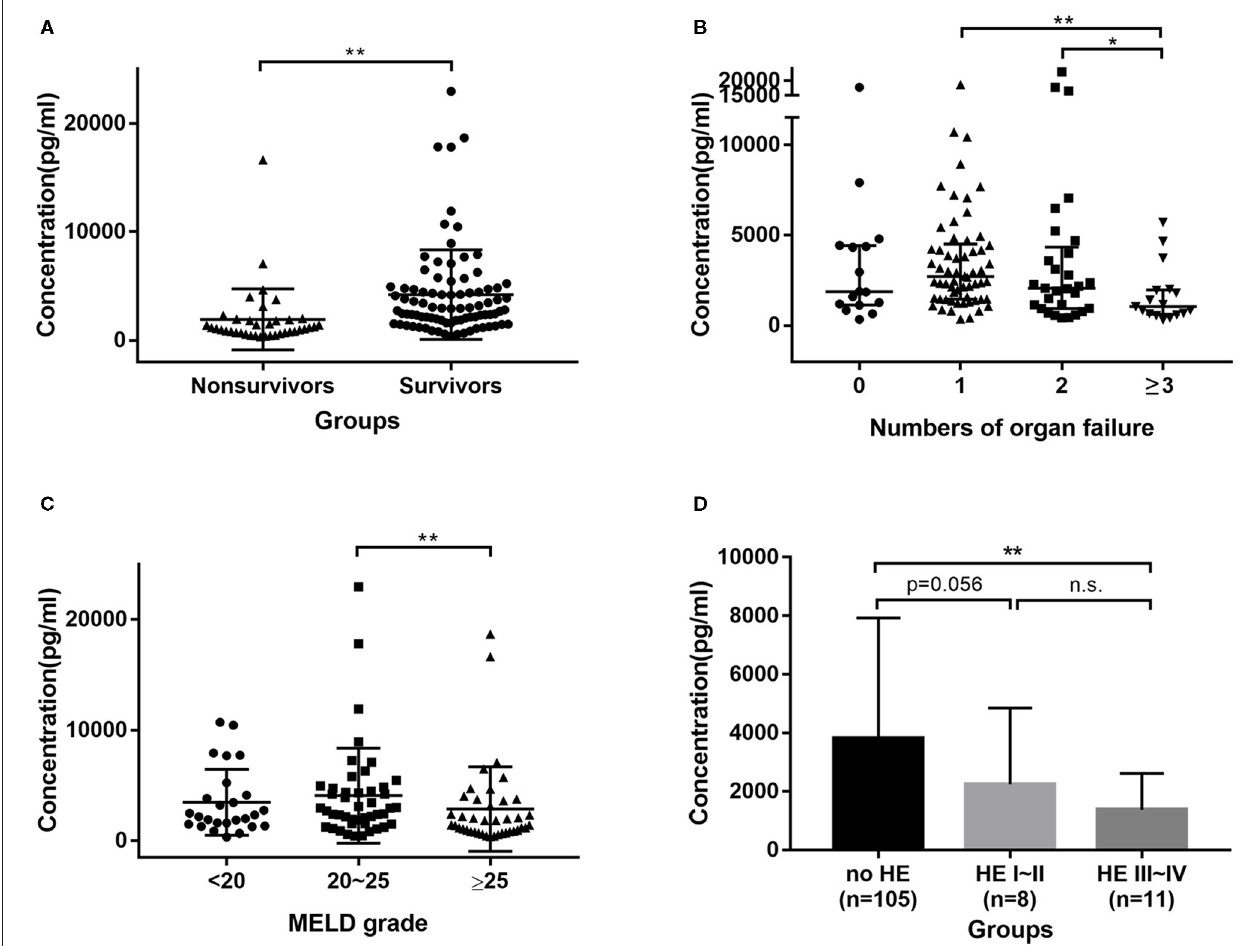
FIGURE 2 | Distribution of GH in HBV-ACLF cohort. (A) GH levels were higher in survivors group than in non-survivors group. (B) Patients with 3 or more organs failure had lower GH levels than patients with 2, 1, or no organ failure. (C) Patients with MELD > 25 had lower GH levels than patients with MELD between 20 and 25. (D) patients with Grade III ∼ IV encephalopathy had lower GH levels than no HE group. * < 0.05, ** < 0.01.